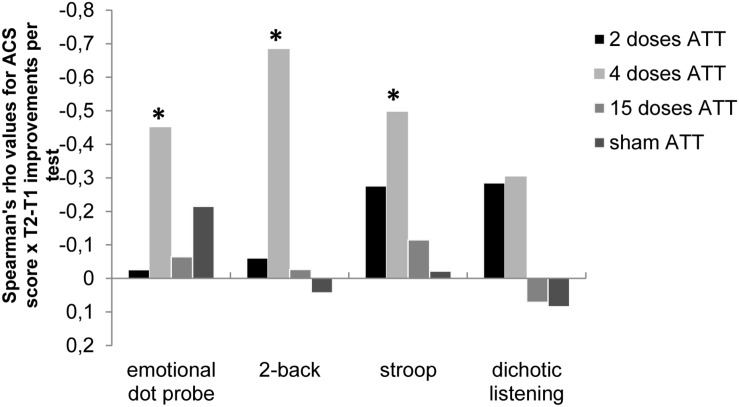
Spearman’s rho correlation values (r) of Attentional Control Scale (ACS; Derryberry and Reed, 2002) scores × performance improvements (T2 – T1) for the respective neurocognitive tests; i.e., the emotional dot probe task, the 2-back task, the emotional Stroop task, and the dichotic listening task are shown dependent on ATT dosage (2, 4, or 15 doses). This illustrates the dose-dependent relationship between self-reported attentional capabilities at baseline and dose-dependent neurocognitive performance improvements, with a significant association of ACS only at four doses of ATT. *p < 0.05.